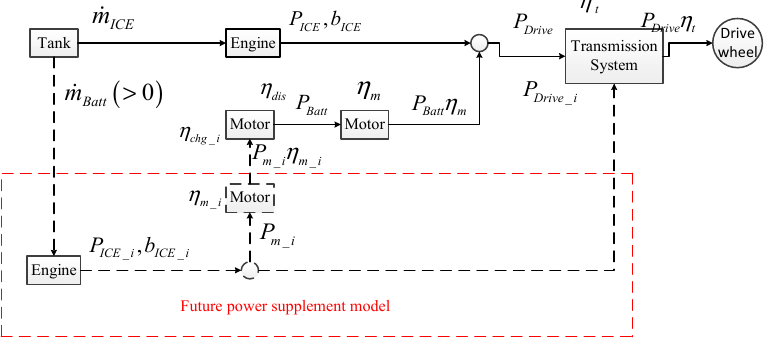
Figure 2. Future power supplement model.